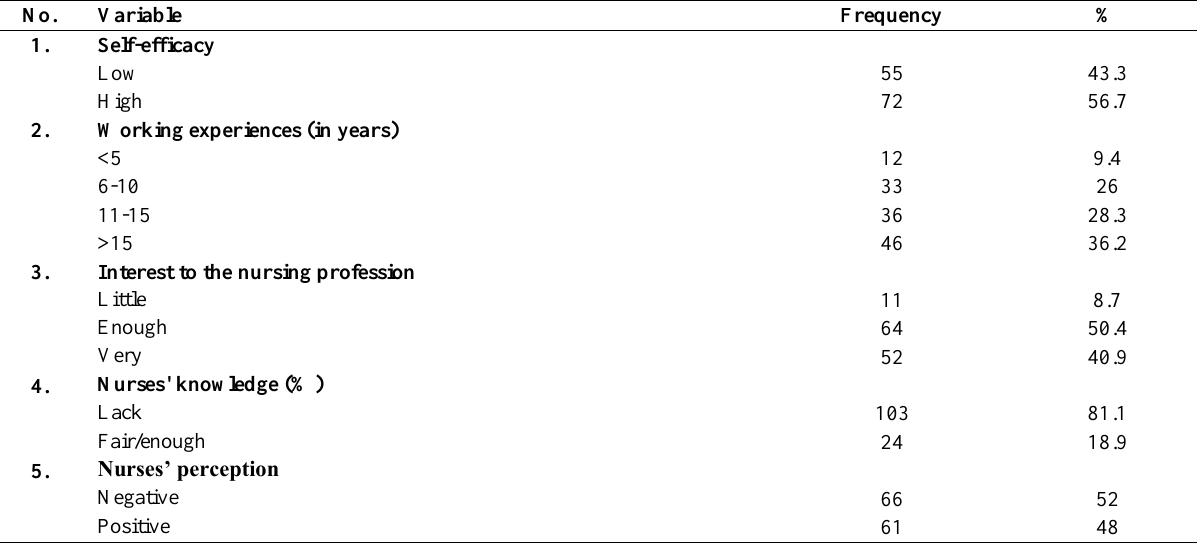
Table 2. Frequency Distribution of Nurses’ Work Experience, Interest to Nursing Profession, Knowledge, Perception and Self-Efficacy Variables in Implementing of Providing PC in ICU (n = 127) No.